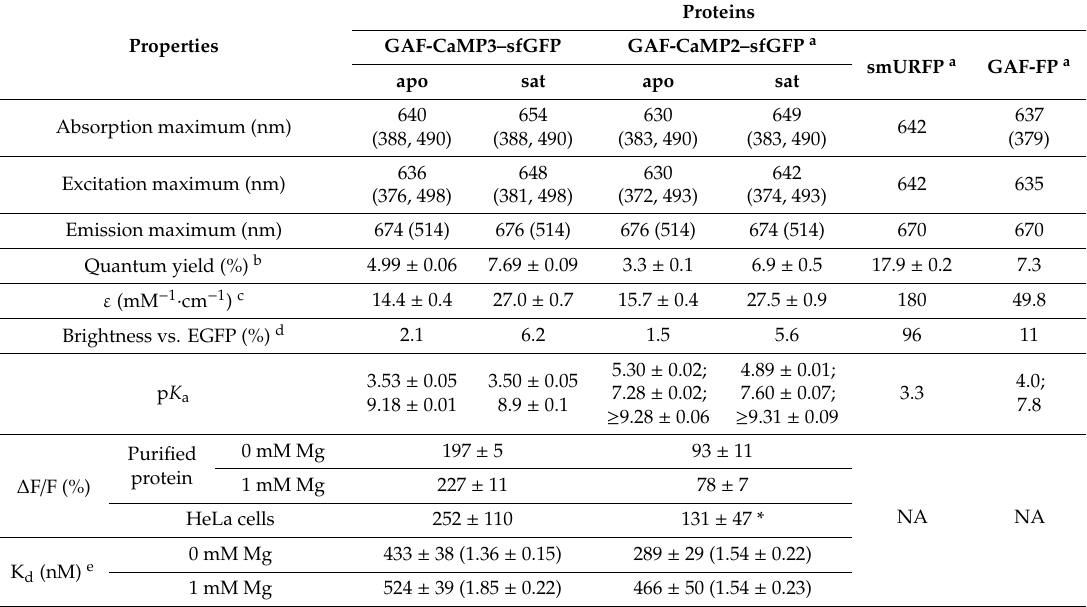
Table 1. In vitro properties of the GAF-CaMP3–sfGFP calcium indicator compared to the parental GAF-